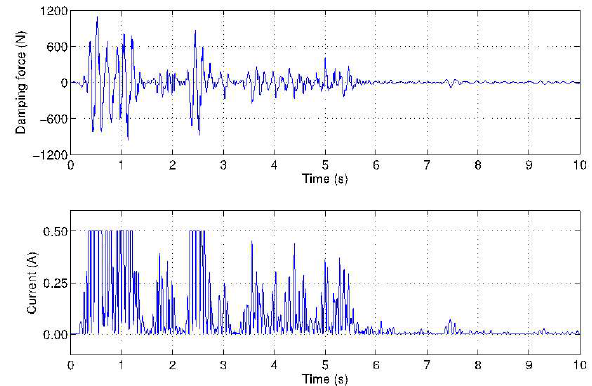
Figure 6: Damper force and corresponding operating current.